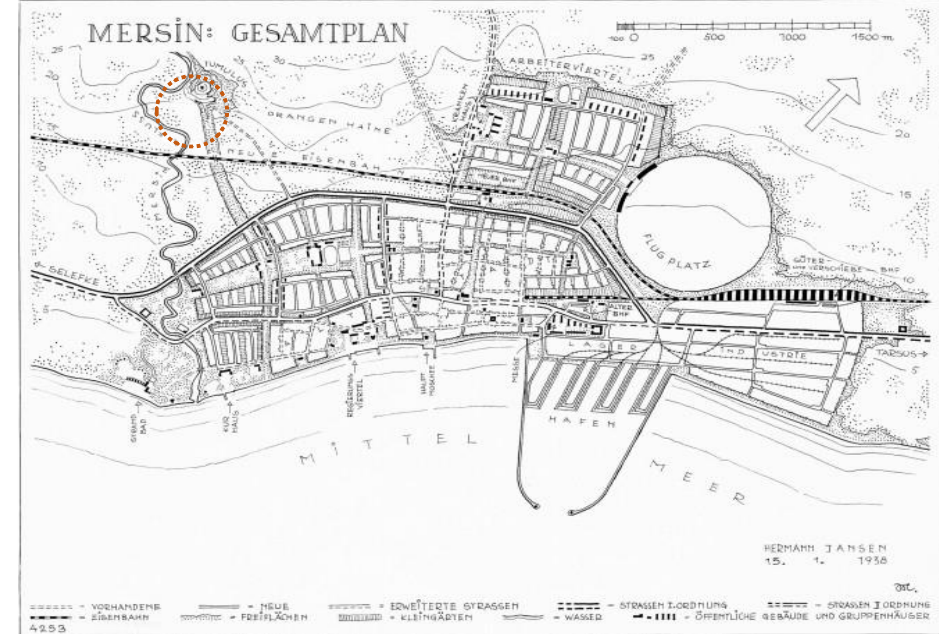
Figure 1 Müftü (Efrenk) Stream as western boundary and Yumuktepe Mound as important landmark of the city in Herman Jansen’s plan for Mersin in 1938 (URL 7)